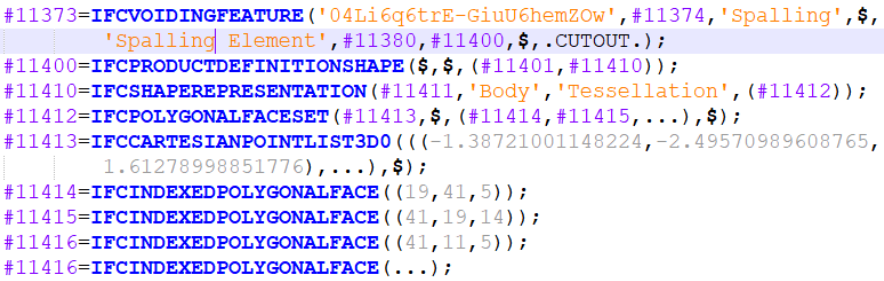
Figure 15. Excerpt of an IFC file with the spalling (#11373) and the geometry